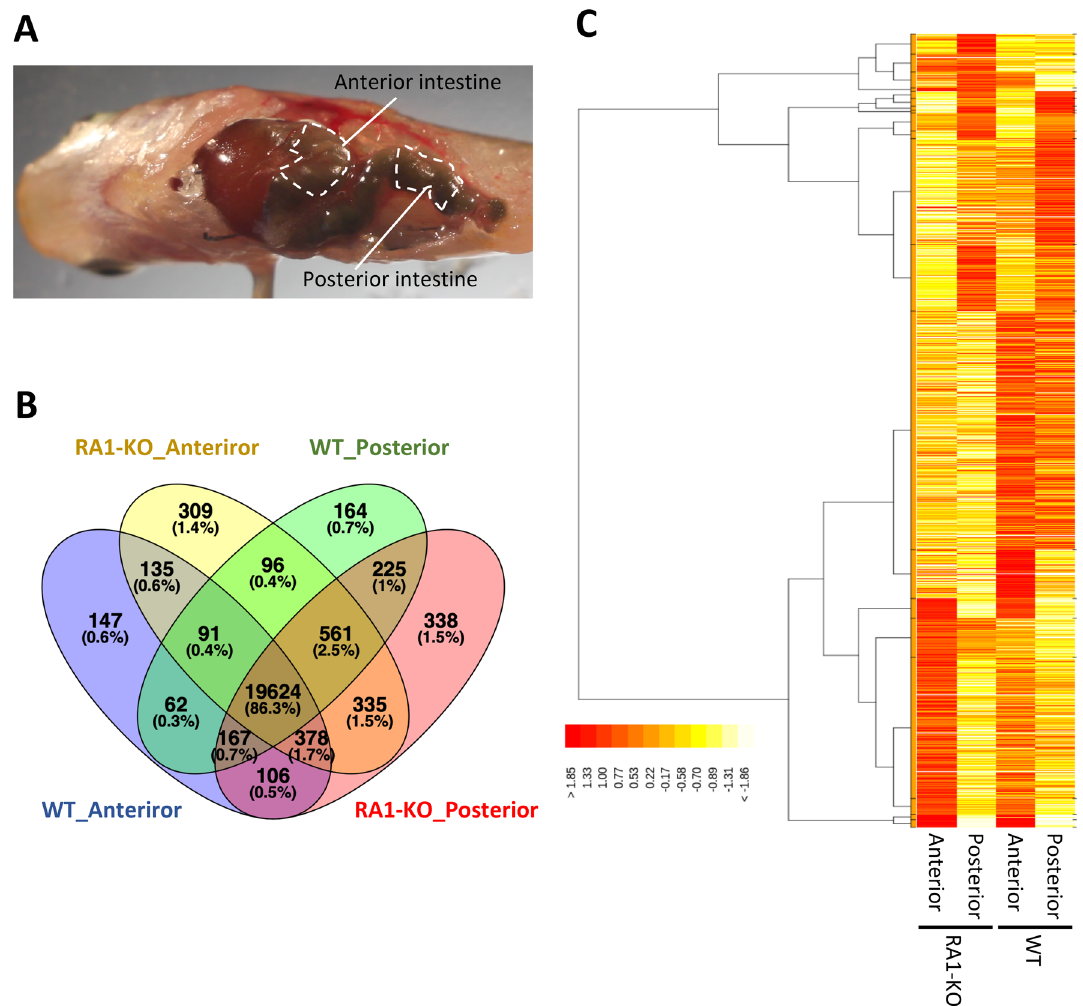
Figure 4. RNA-sequencing (RNA-seq) analysis of samples of the anterior and posterior intestines of WT and IL-17RA1-KO medaka. ( A ) Complementary DNA libraries were constructed with the selected intestines, as shown in the picture, and the analyzed samples were divided into two sections (anterior and posterior). ( B,C ) The overall gene-expression patterns are shown for each group (WT_Anterior, RA1-KO_Anterior, WT_Posterior, and RA1-KO Posterior). ( B ) The Venn diagram shows the numbers of expressed and overlapping genes expressed in each group. ( C ) A heat map was also used to visualize differences in the overall gene- expression patterns among the different groups. The heat map was constructed using TCC-GUI